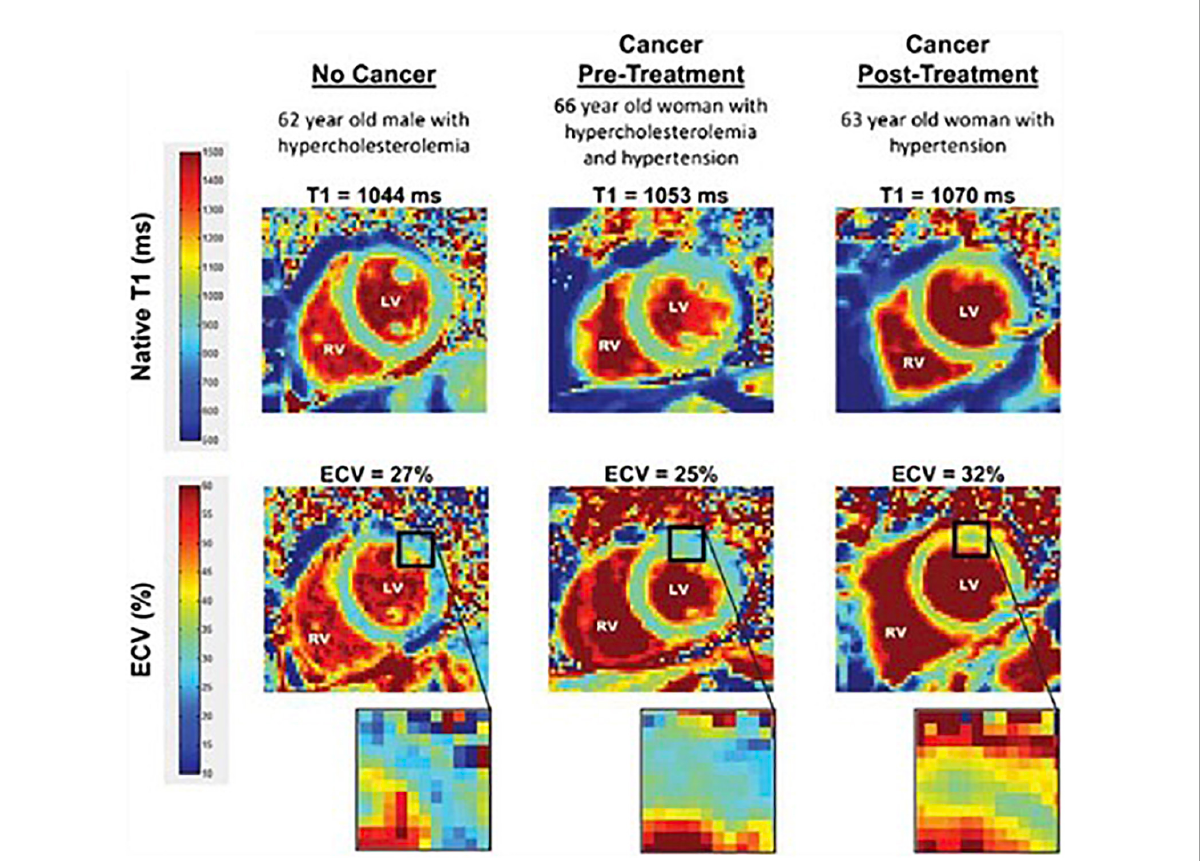
FIGURE7 Comparison of T1 and ECV map images. Representative left ventricular (LV) short-axis native T1 (top row) and extracellular volume (ECV, bottom row) maps are shown in similarly aged participants. The LV and right ventricular (RV) blood pool cavities are noted. On each image, the color of pixels in the images (color scales on left) identifies the native T1 (milliseconds) and ECV (%). Insets on the ECV maps demonstrate the change in color intensity within the anterolateral wall of each ventricle. As shown, ECV is elevated in the cancer survivor previously treated with anthracycline-based chemotherapy. From Jordan et al. (56) with